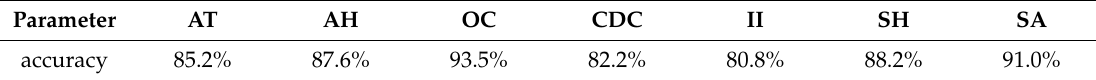
Table 5. The performance evaluation without each parameter.